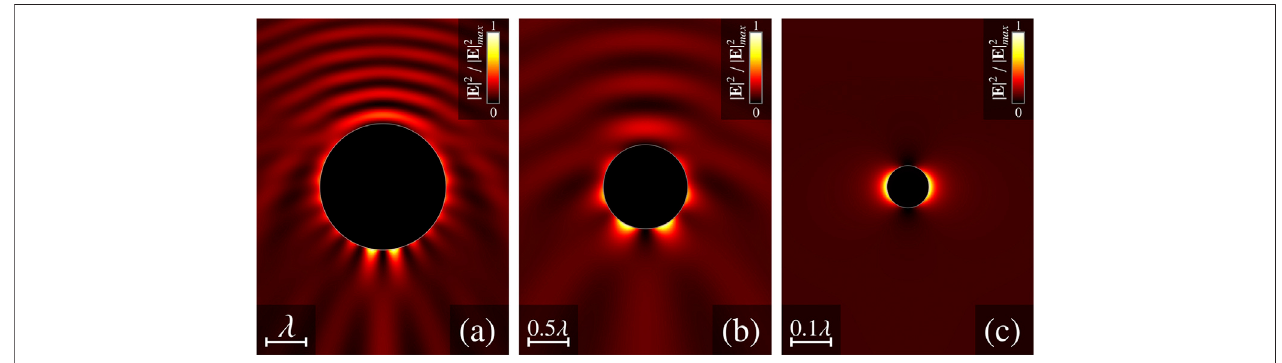
FIGURE 4 | Diffraction on the metal spherical particle: near- fi eld intensity distributions in the x - z plane. The incident wave is a non-vortex Gaussian beam ( LG 0,0 ). f (cid:2) 0.02 λ and ϵ p / ϵ med (cid:2) − 22.5 + 1.4 i . (A) — R p (cid:2) 1.5, (B) — R p (cid:2) 0.5, and (C) — R p (cid:2) 0.05.